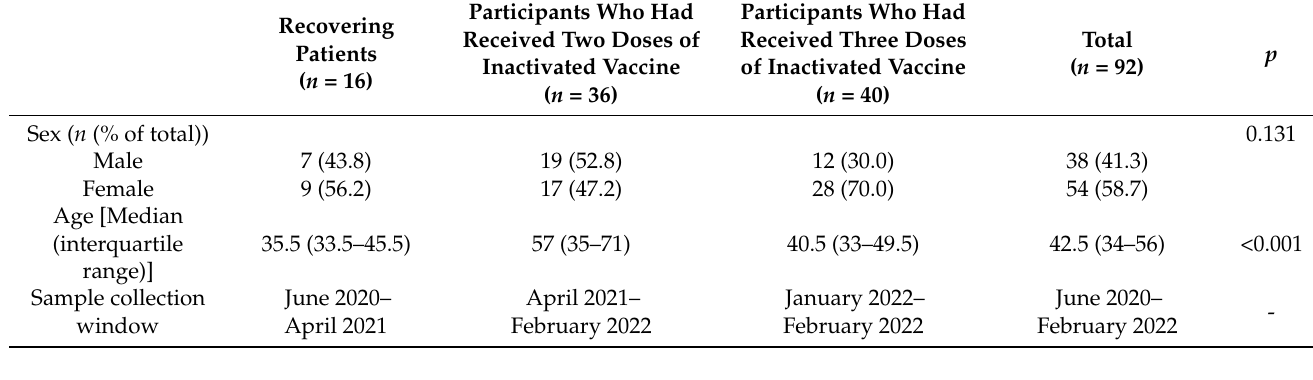
Table 1. Sociodemographic characteristics of the participants.